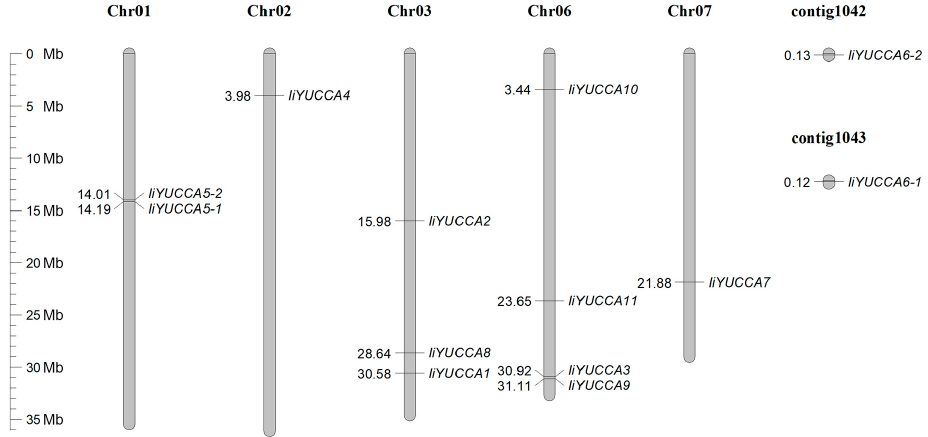
Figure 1. The chromosomal locations of YUCCA genes from I. indigotica . The scale represents a 35-Mb chromosomal distance. The numbers above represent the location of each gene.